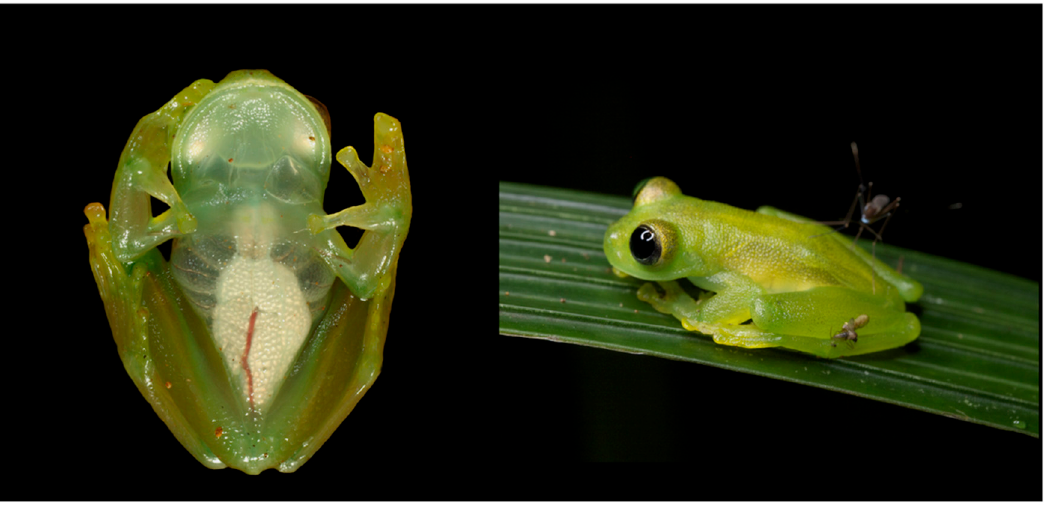
Figure 207. Teratohyla amelie in life. Left : Adult male, QCAZ 37920, Ecuador, Pastaza province, stream tributary of Río Lliquino, 350 m (photo by Martín Bustamante). Right : Adult male, QCAZ 47204, Ecuador, Pastaza province, Reserva Ecológica Río Anzu, 1200 m. Photo by Lucas Bustamante/Tropical Herping.